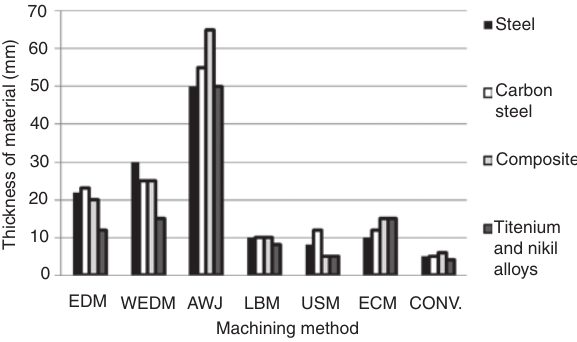
Figure 9: Comparison of cutting methods in terms of material